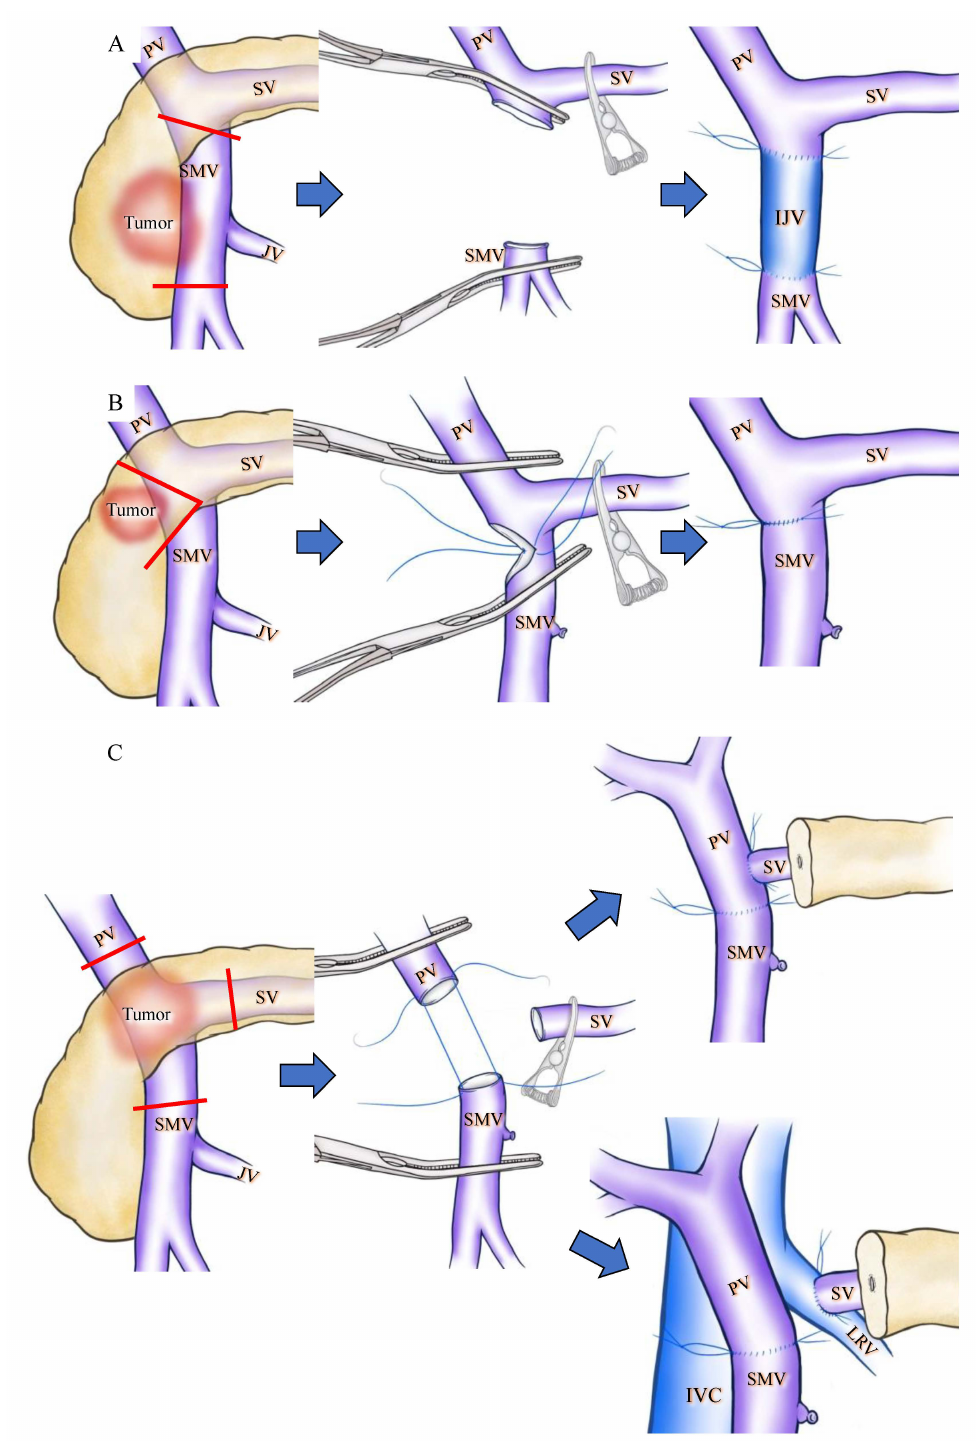
Figure 2. Schematic drawings before and after superior mesenteric vein (SMV) or splenic vein (SV) reconstruction during pan-creaticoduodenectomy (PD). Red lines indicate cut lines of PV, SMV and SV. ( A ) Wide resection of the SMV under SV confluence was performed. IJV was used as the interposition graft. ( B ) Wedge resection of the SMV was performed, and the SMV was reconstructed by direct running suture in a transverse fashion. ( C ) The PV, SMV, and SV were cut as close to the specimen as possible, and SV-PV anastomosis (upper side) and SV-LRV anastomosis (lower side) were performed. IJV: internal jugular vein; IVC: inferior vena caca; LRV: left renal vein; PV: portal vein; SMV: superior mesenteric vein; SV: splenic